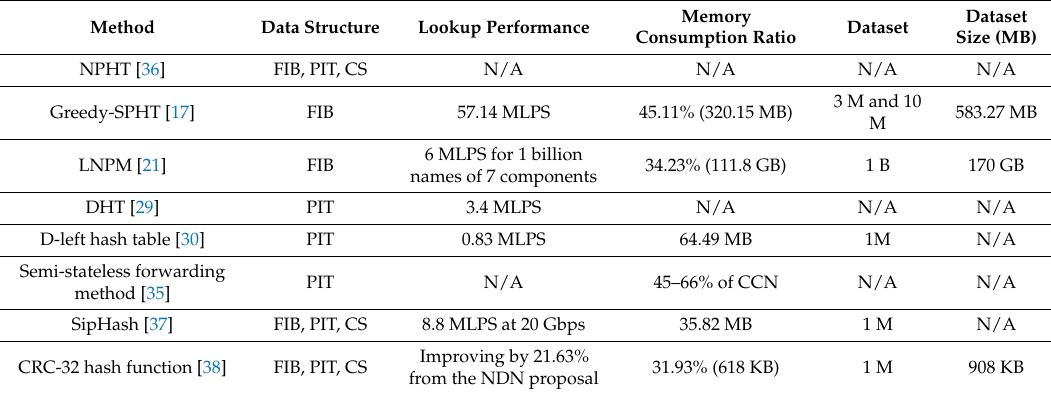
Table 5. Comparison of lookup throughput based on HT